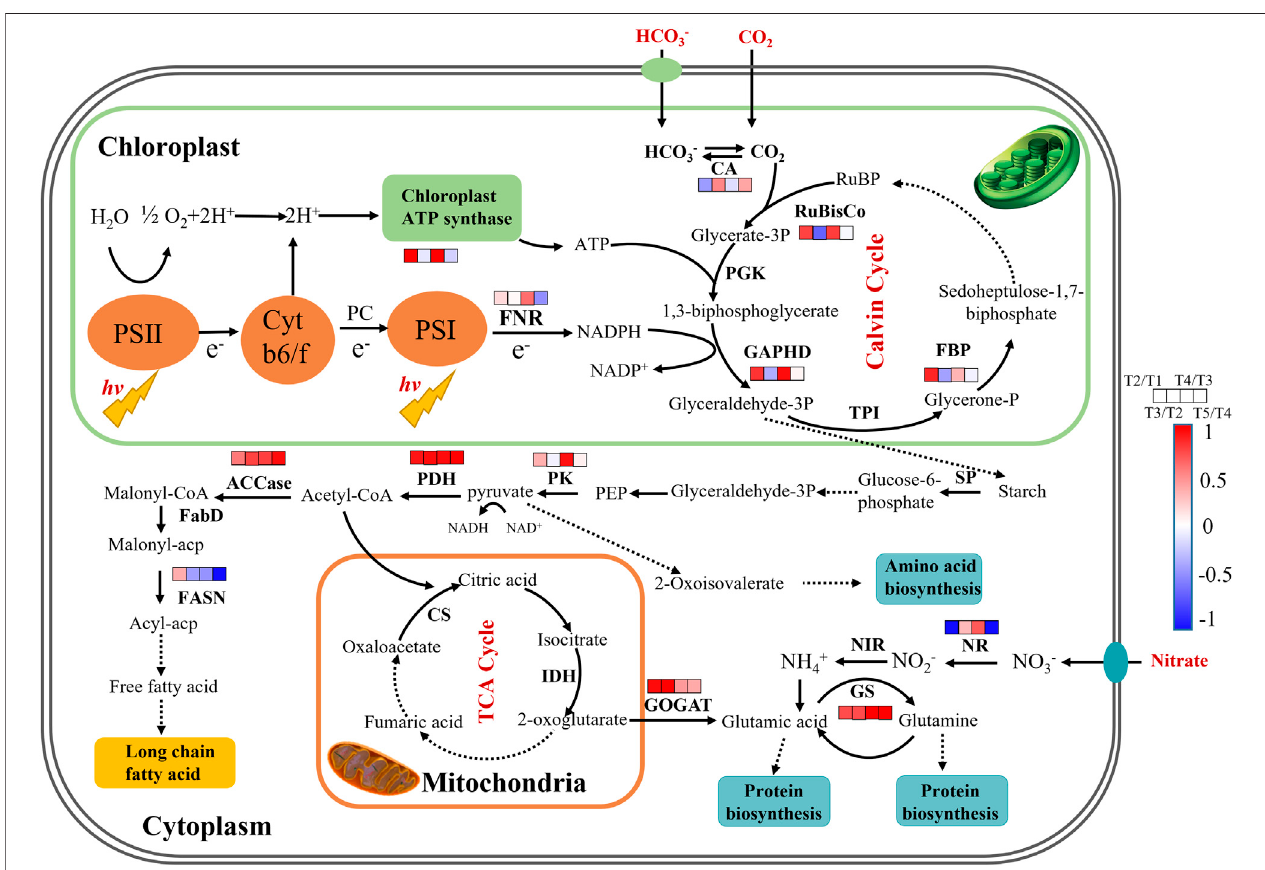
FIGURE5| Theproposedpathwaysofenhanced CO 2 fi xation andproteinbiosynthesis inautotrophic C.subellipsoidea during repeated fed-batchculture ina5-L photo-fermenter. The changes in expression levels of key genes are presented at the time points of 48, 120, 144, 192, and 288 h as T1, T2, T3 and T4, and T5, respectively. Red boxes represent the upregulation of key genes, blue boxes represent the downregulation of key genes, and white boxes represent no signi fi cant changeinexpressionofkeygenes.Solidarrowlinesrepresentthedirectreactionsbetweenthemetabolites,anddasharrowlinesrepresentthemultistepreactions among those